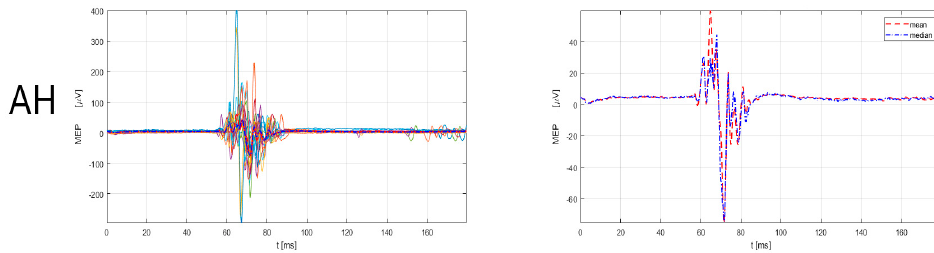
Figure 4. MEP responses for lower extremity (AH) muscle, left side for No3 subject. Left: superim- posed responses, Right: mean and median responses. AH = abductor hallucis. Legend: the red dashed line denotes the mean response of all MEPs, and the blue dash-dotted line represents the median response of all MEPs. MEP latency and amplitude estimation was performed by a custom- made Matlab script (R2021a) using an automatic algorithm, developed by Šoda et al. (2020) [68].